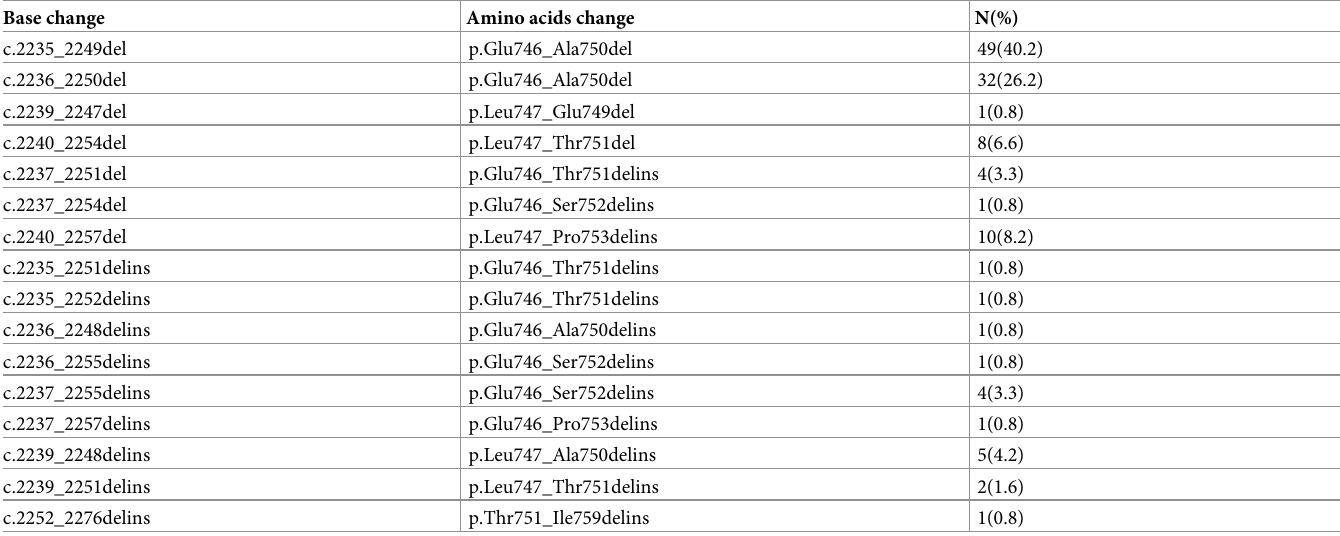
Table 2. Mutation subtypes of 122 EGFR exon19